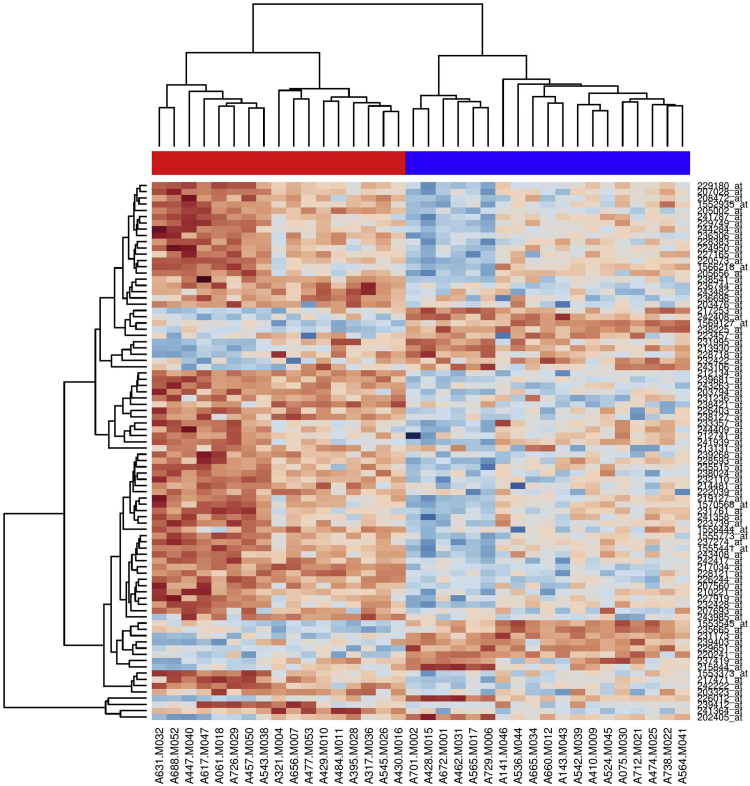
Heatmap and dendrogram of the differential gene expression profiles for 86 gene markers with at least 1.5 fold up- or down- regulation, generated from post-intervention HEP and MAP samples using RMA normalization. The HEP group is colored in blue and MAP group is in red. The relative expression level of each gene among all the tested samples have been assigned sequentially from dark red color to dark blue color in accordance with low to high expression level.